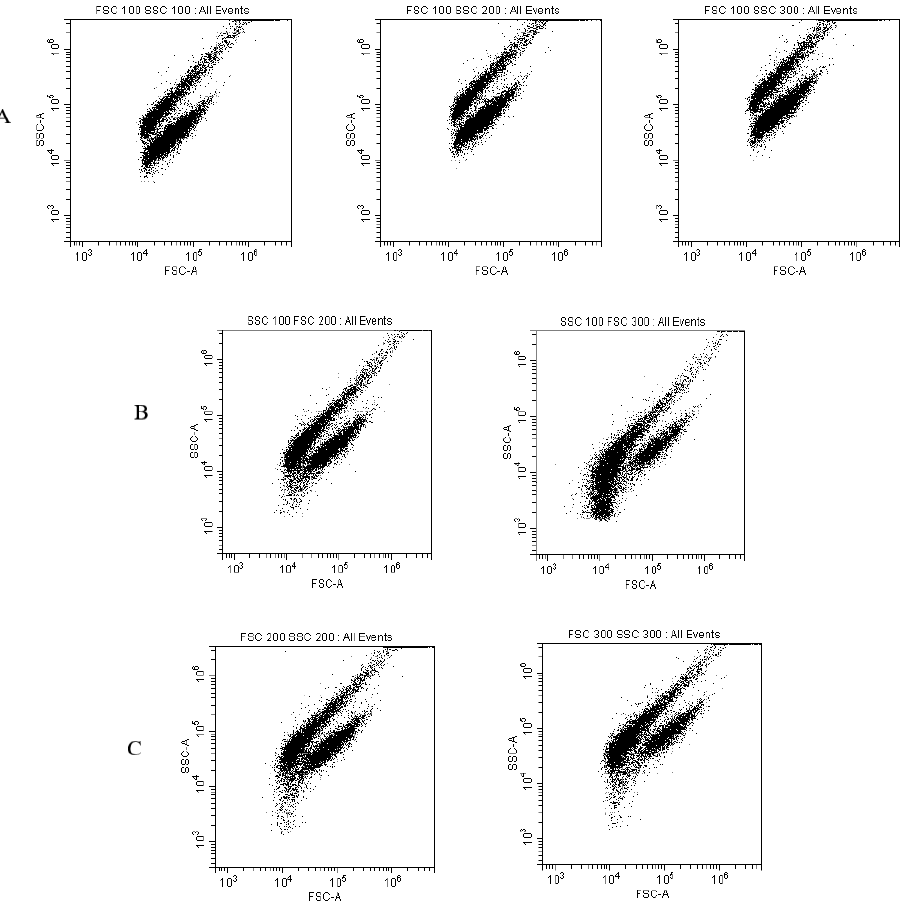
Figure 7. Different combinations of gain settings of FSC and SSC channels. ( A ) FSC, 100; SSC 100–300; ( B ) FSC, 200; SSC, 200–300; and ( C ) FSC, 200–300, SSC, 200–300.